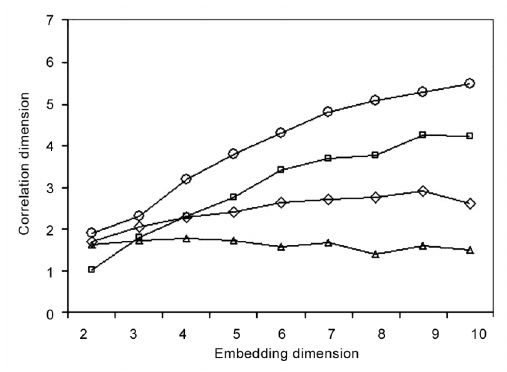
Fig. 10. Correlation dimension versus embedding dimension of waiting times sequences of the whole catalogue: diamonds – integral time series (1975- 1996); squares – before beginning of experiment (1975-1983); triangles – during experiments (1983- 1988); circles – after experiments (1988-1992).